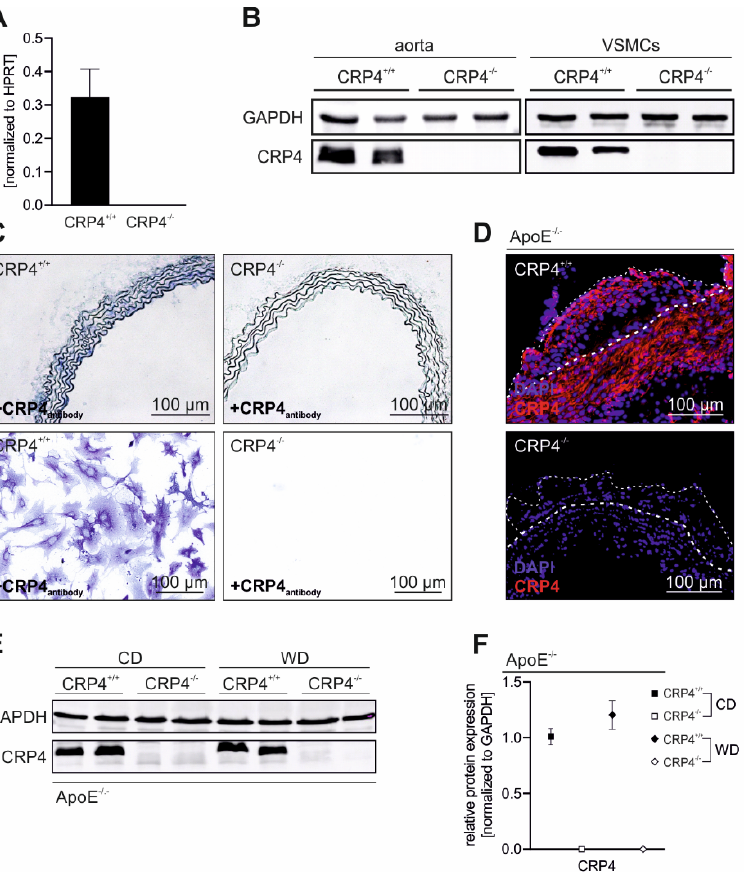
Figure 1. CRP4 is expressed in VSMCs, in the tunica media and in atherosclerotic lesions ; ( A ) Quantitative polymerase chain reaction (qPCR) of CRP4 transcripts purified from isolated P0 VSMCs. ( B ) Western blot of the CRP4 protein expression in CRP4 WT and CRP4 KO aorta and in P10-15 VSMCs; n = 8 per genotype; data represent the mean ± SEM. Hypoxanthine phosphoribosyl transferase 2 (HPRT2) was co-amplified as a housekeeping gene in the qPCR approach ( A ) while glyceraldehyde-3-phospate dehydrogenase (GAPDH) was co-detected as a loading control in the Western blot analyses ( B ). ( C ) Representative CRP4 expression (blue) in CRP4 WT and KO aorta cryosections and in isolated P0 VSMCs by alkaline phosphatase (AP) staining. CRP4 (red) and DNA (Hoechst) were visualized ( D ) by immunofluorescence in aortic arch cryosections of 16-week WD-fed ApoE − / − /CRP4 +/+ and dKO mice. Plaque and media margins are highlighted by thin and thick dashed lines (white), respectively. ( E , F ) Western blot and its quantification of CRP4 in ApoE − / − /CRP4 +/+ versus dKO aortic lysates from WD and CD conditions. The CPR4 protein levels in WT samples were not altered by the diets, while the absence of CRP4 was again confirmed under WD and CD in dKO; n = 3–4 per genotype (every n was a pool of two aorta) and two-tailed Student’s t -test. All data are expressed as the means ± SEM.